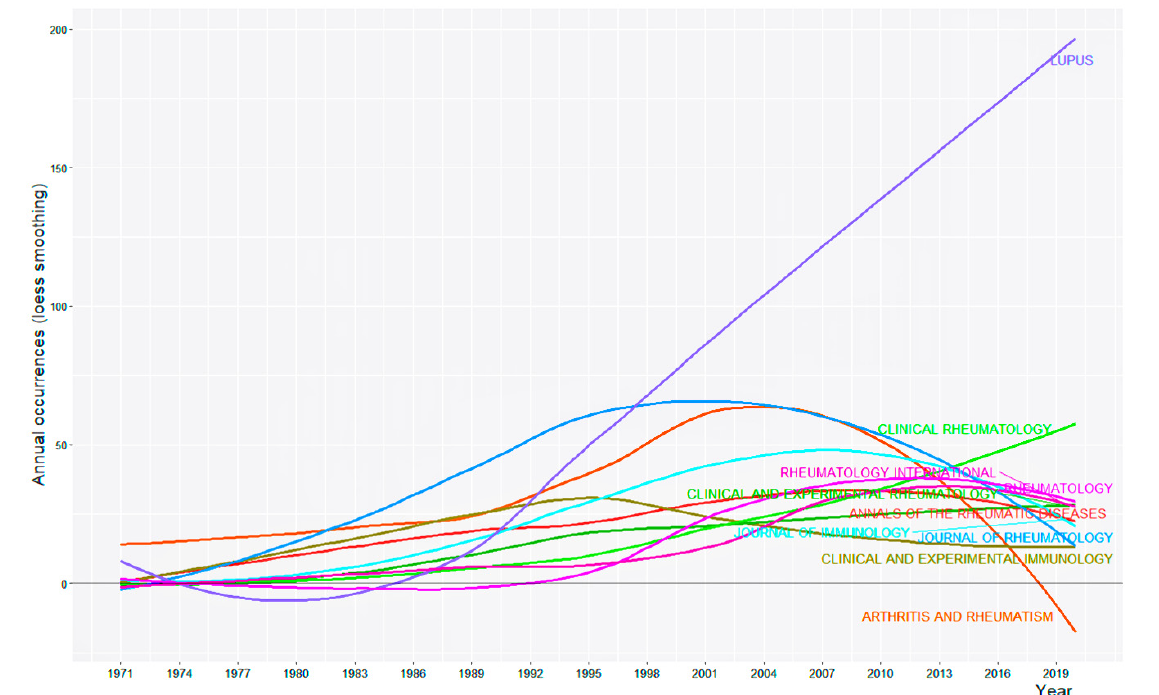
Figure 2. Plot of annual occurrence of articles in the top 10 journals from 1971 to 2020.